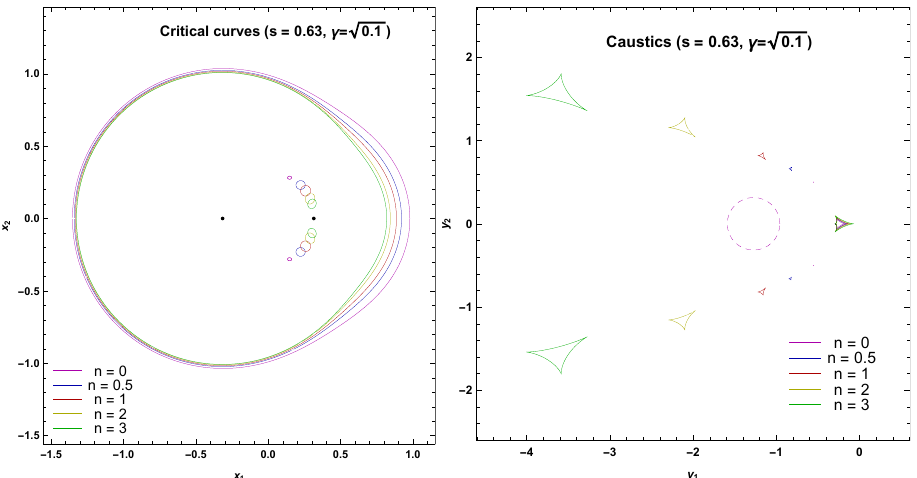
Figure 16. Critical curves and caustics in the unequal-strength binary with the standard lens on the right, close